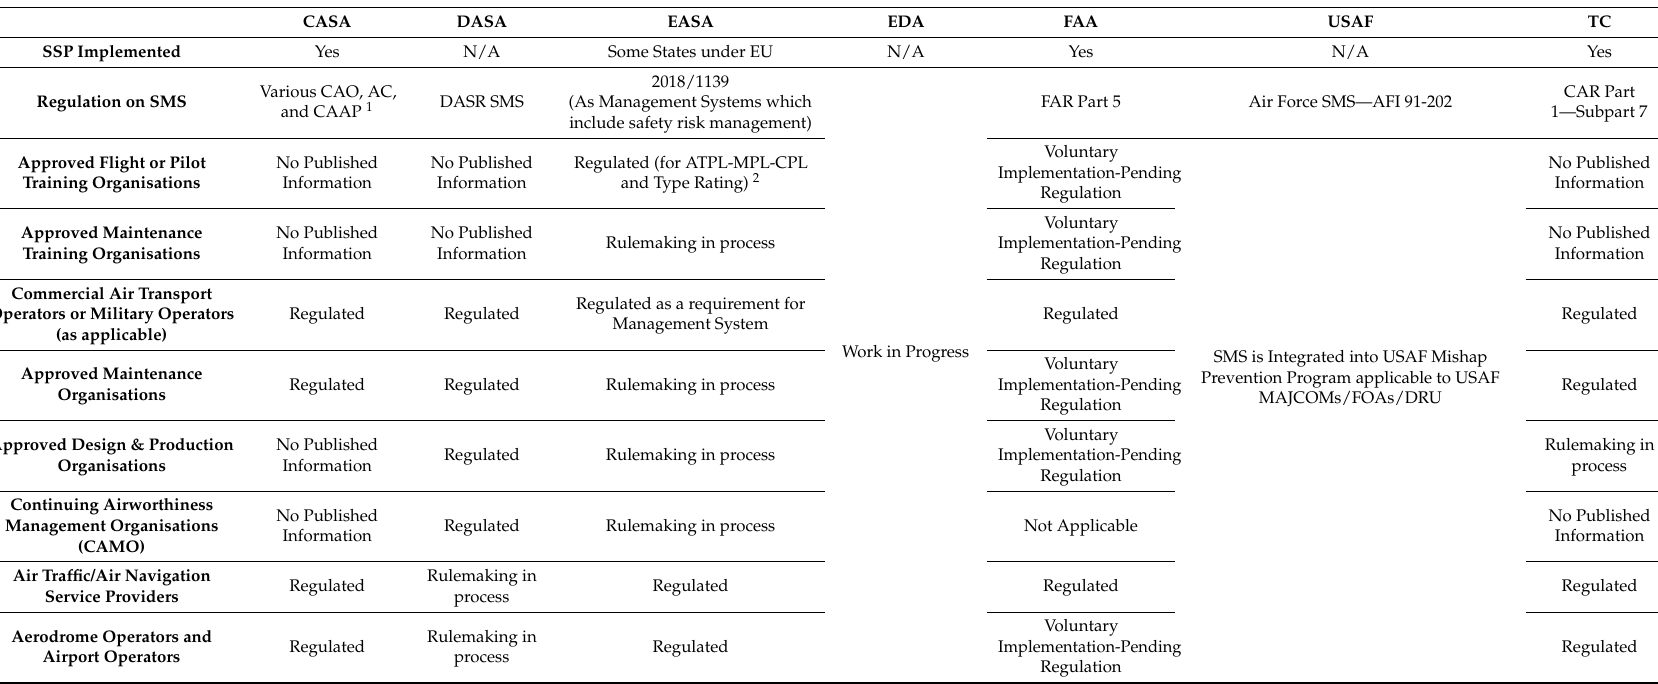
Table 1. Status of SMS regulation under key NAA and MAA (as at June